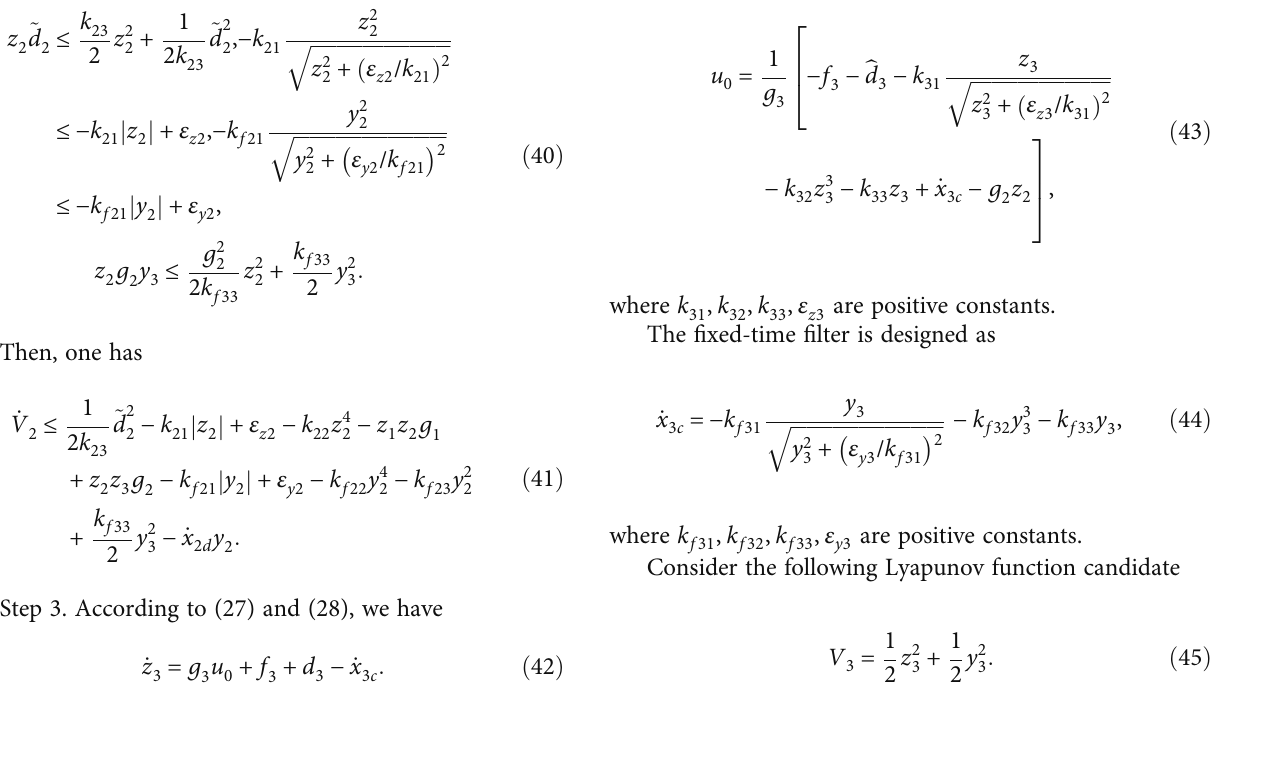
Figure 4: Tracking error e